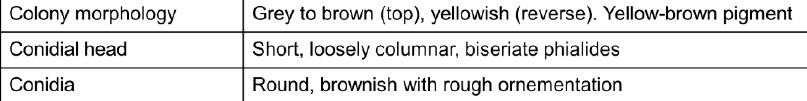
Figure 1. Morphological aspects of Aspergillus calidoustus. Macroscopic aspect of the colony on Sabouraud dextrose agar medium, top ( left ) and reverse ( middle ). Microscopic aspect (1000 × ) of a conidial head (staining: lactophenol blue) ( right ). Note: rough ornamentation of conidia is not visible here and could better visualized by scanning electron microscopy.